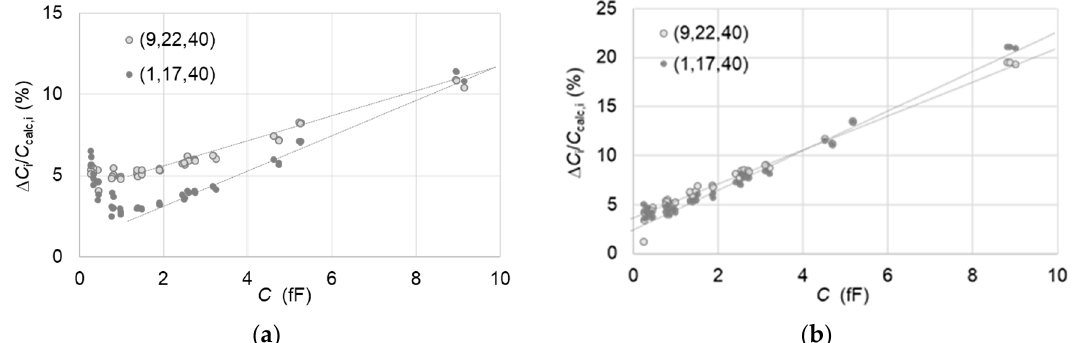
Figure 7. ( a ) Differences Δ C i / C calc,i = ( C i,A45 − C i,A61 )/ C calc,i in percentage between the measured values C i,A45 on the 48 capaci- tors of A61F08 pattern when the SMM is calibrated using the triplet (9,22,40) (full circles) or (1,17,40) (empty circles) from A45E08 pattern and the measured values C i,A61 when the SMM is calibrated with the same triplets from A61F08. ( b ) Dif- ferences Δ C i / C calc,i = ( C i,A64 − C i,A61 )/ C calc,i with the patterns A61E07 and A64F07 which replace A61F08 and A45E08, respec- tively. The dashed straight lines are used only to guide eyes. The error bars varying between 2% and 3% have been omitted for clarity.